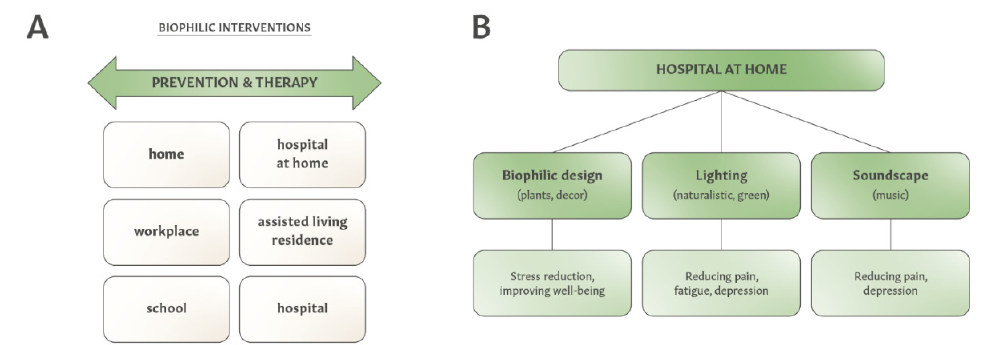
Figure 3. Applications of biophilic interventions and health-related interior landscapes in diverse indoor environments. ( A ) Examples of diverse indoor environments amenable to health-related interior design. ( B ) Examples of therapeutic interior design elements and their clinical benefits for hospital at home care.